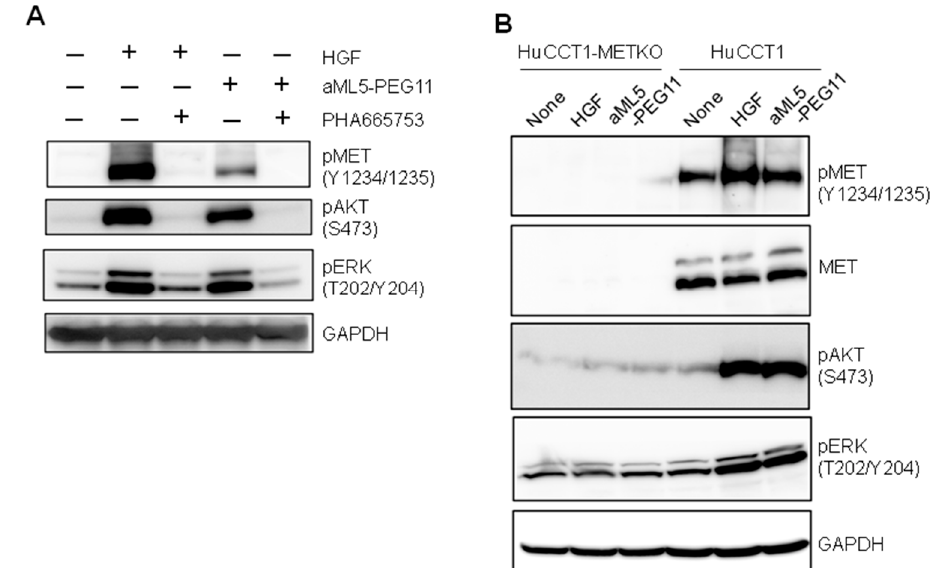
Figure 4. MET-receptor-dependent AKT and ERK phosphorylation by aML5-PEG11. ( A ) Effect of a selective MET tyrosine kinase inhibitor on aML5-PEG11-induced phosphorylation in MET, AKT, and ERK. EHMES-1 cells were pre-treated with or without 100 nM PHA-665752 overnight and stimulated with 100 nM aML5-PEG11 or 3.3 nM HGF for 10 min. Phospho-MET receptor at Try 1234/1235, phospho-AKT, and phospho-ERK were detected by Western blotting. GAPDH